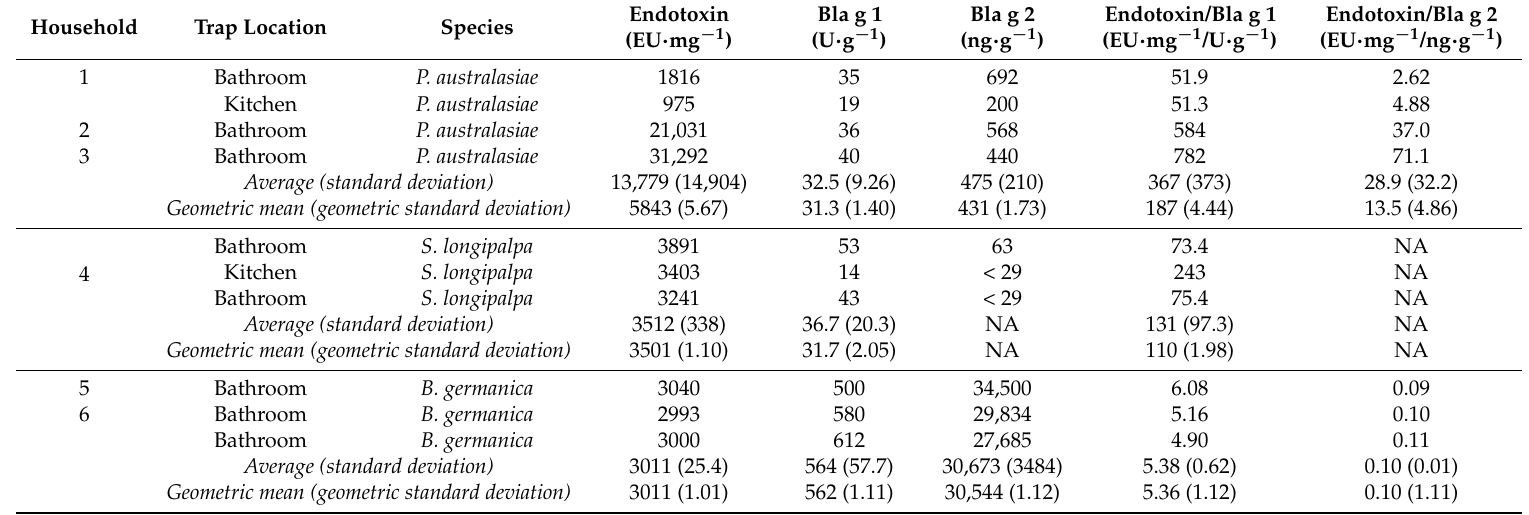
Table 1. Endotoxin and allergen levels in cockroach feces.